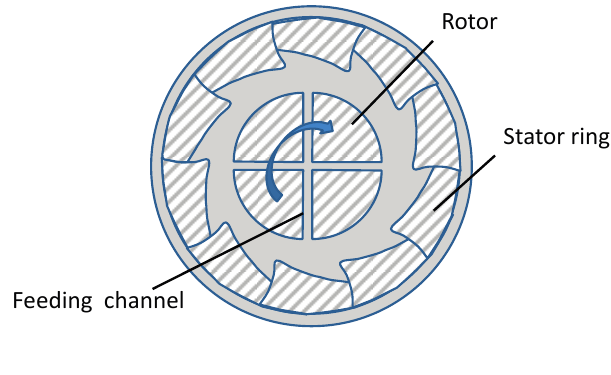
Figure 10. Rotary impact